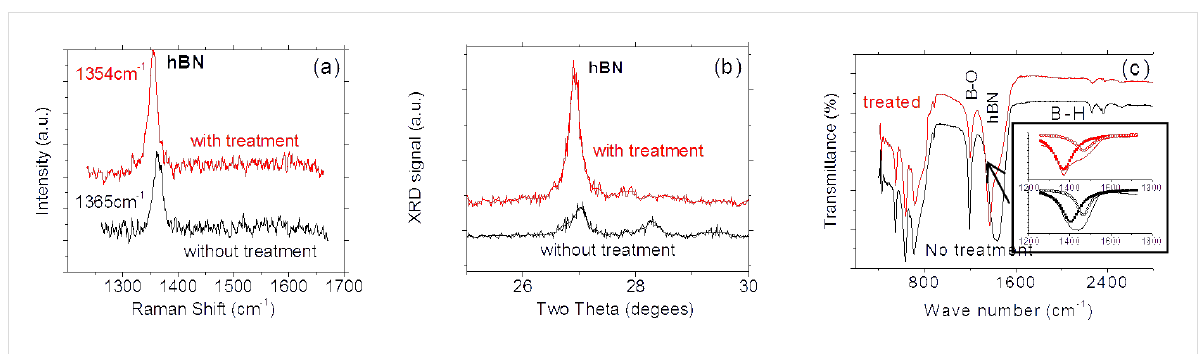
Figure 7: (a) Raman scattering, (b) XRD, and (c) FTIR transmittance spectra of the BNNSs before and after functionalization. Red shifts of all spec- tral lines is clear visible after functionalization.